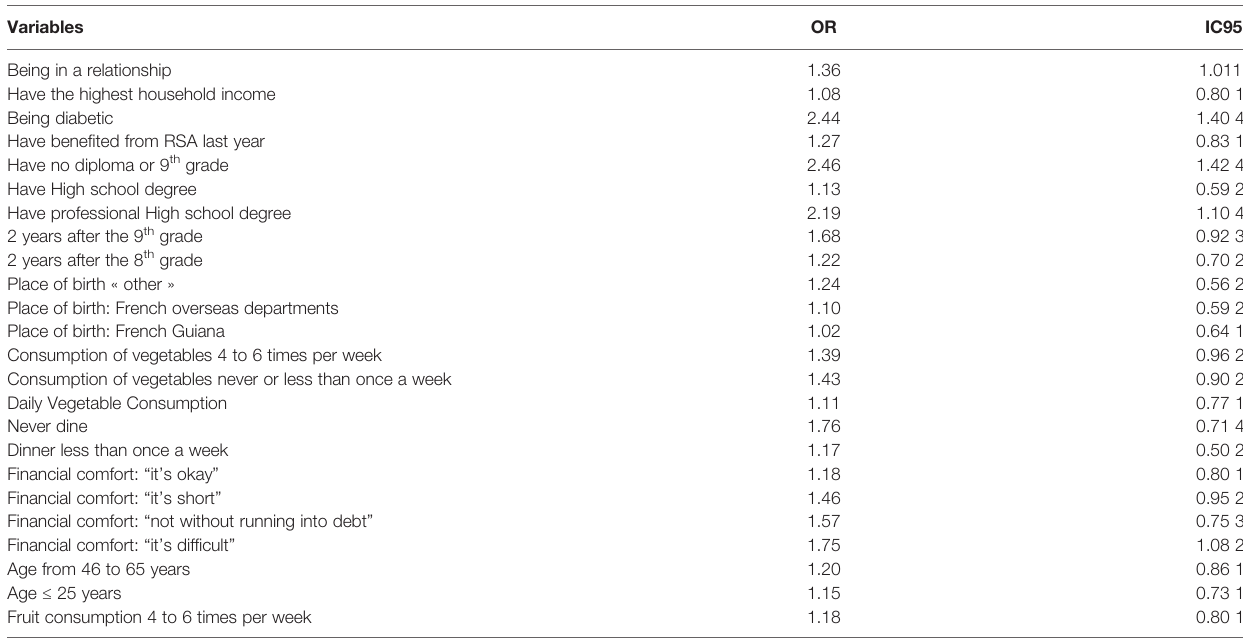
TABLE 4 | Logistic regression results